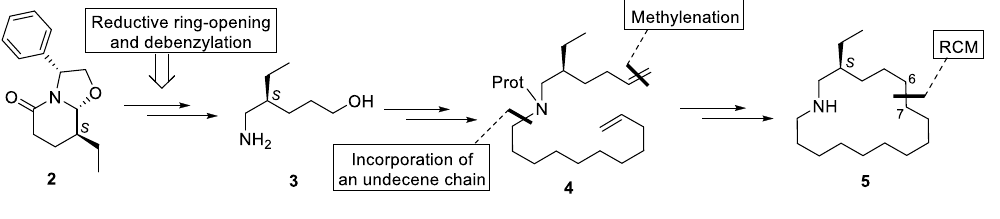
Figure 1. Azamacrocyclic marine alkaloids isolated from Haliclona tulearensis